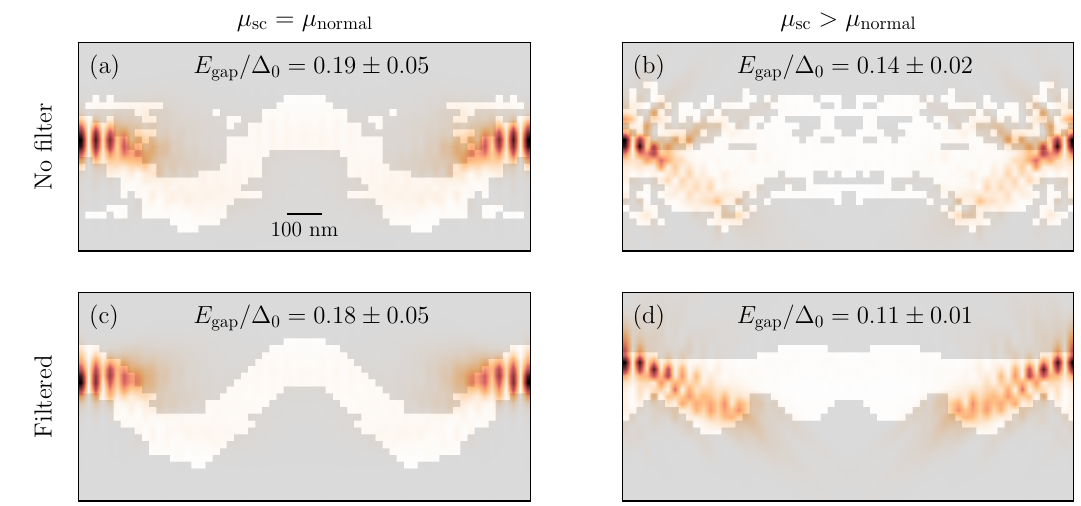
Figure 4: The effect of introducing median-filtering in the optimization algorithm. The top panels (a) and (b) show optimized geometries when starting from a straight junction with homogeneous and mismatched chemical potentials, respectively. The bottom panels (c) and (d) show the geometries obtained when a median filter is added. Each panel also shows the average gap over the range of µ and E the optimization (see main text for exact